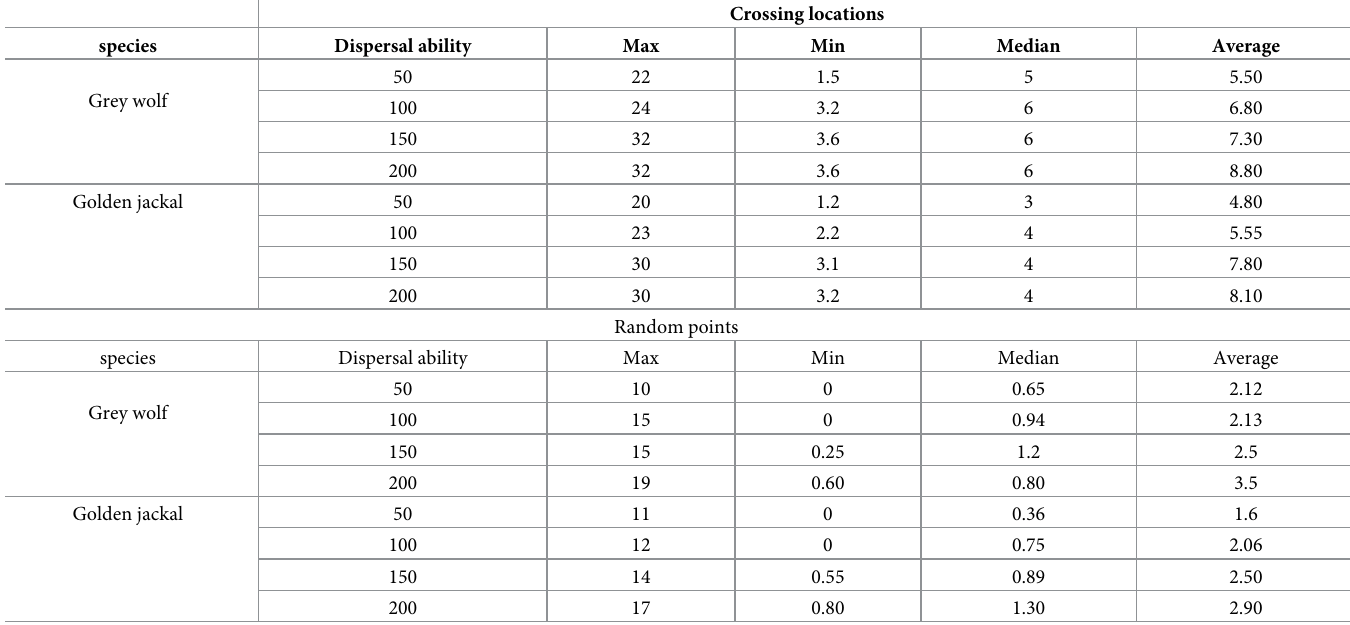
Table 6. Maximum, minimum, median, and average value of grey wolf and golden jackal crossing locations compare with 10000 random